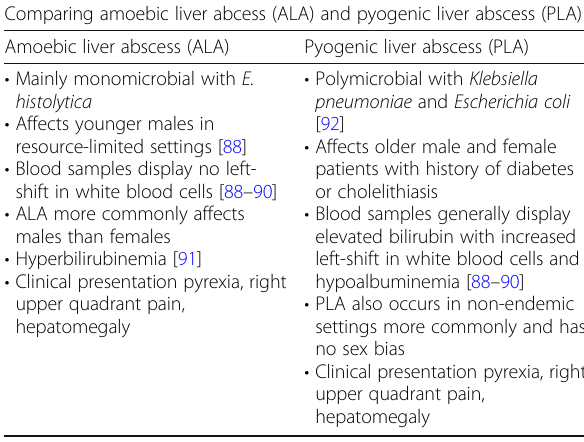
Table 1 Differences between ALA and PLA Comparing amoebic liver abcess (ALA) and pyogenic liver abscess (PLA) Amoebic liver abscess (ALA) Pyogenic liver abscess (PLA) (cid:129) Mainly monomicrobial with E.